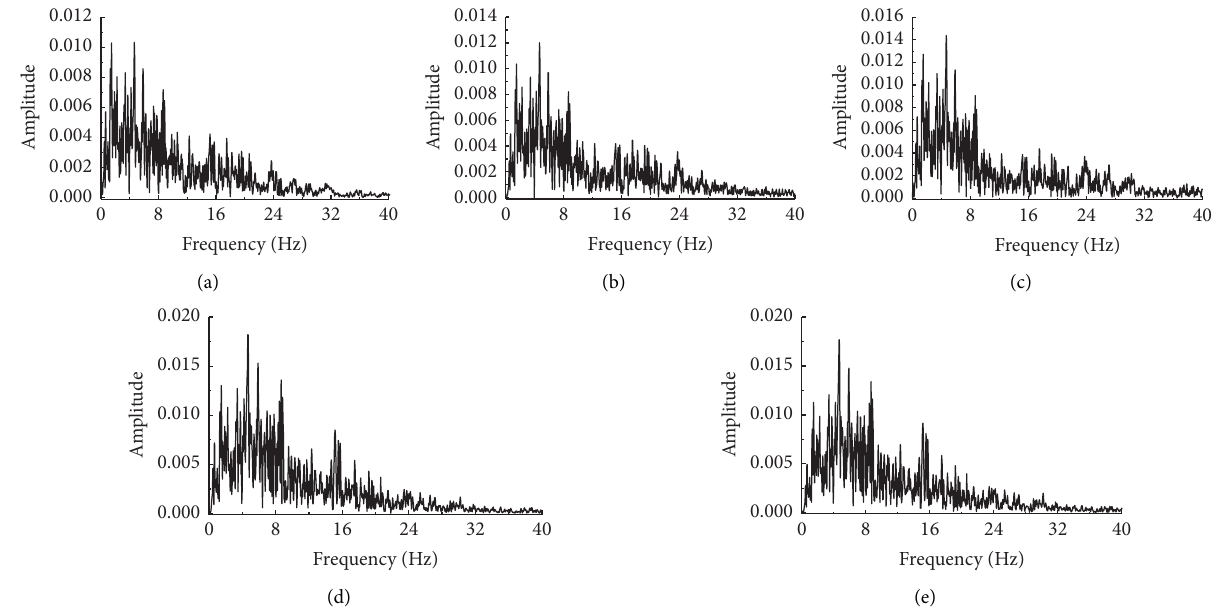
Figure 12: Test 3 acceleration Fourier spectrum of soil layer. (a) A1. (b) A2. (c) A3. (d) A4. (e) Table 6: Strain peak of structure under EL wave ( με ). Measuring point